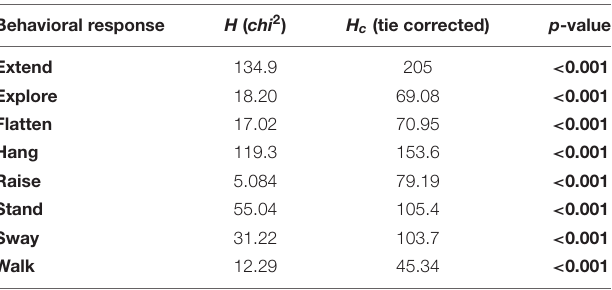
TABLE 4 | Differences in individual behaviors between experimental groups, for behaviors that significantly contributed to the distribution pattern during NMDS. Behavioral